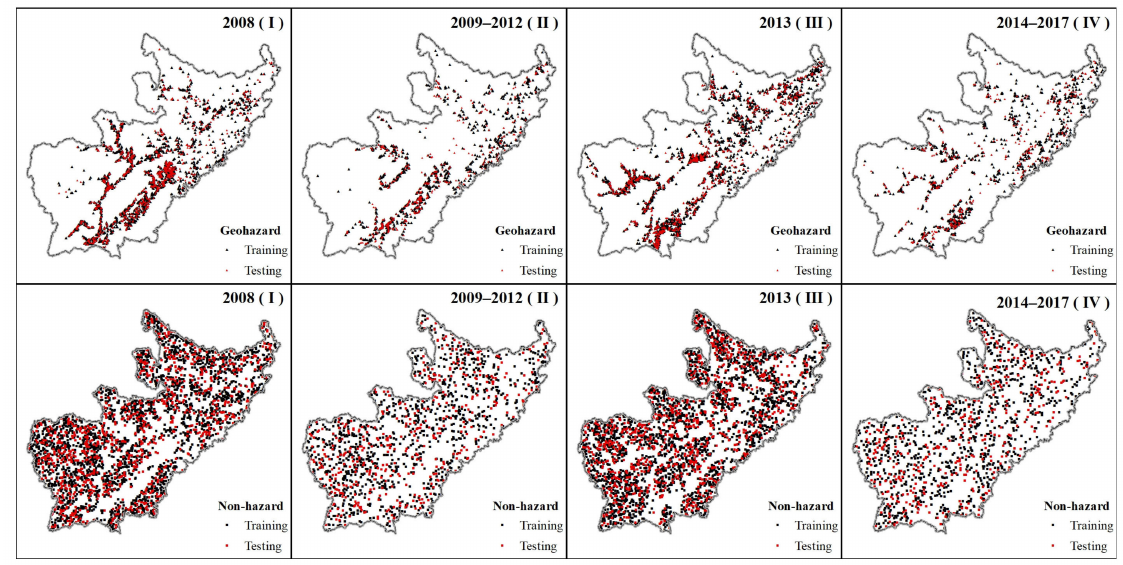
Figure A1. Training set and testing set in four periods.